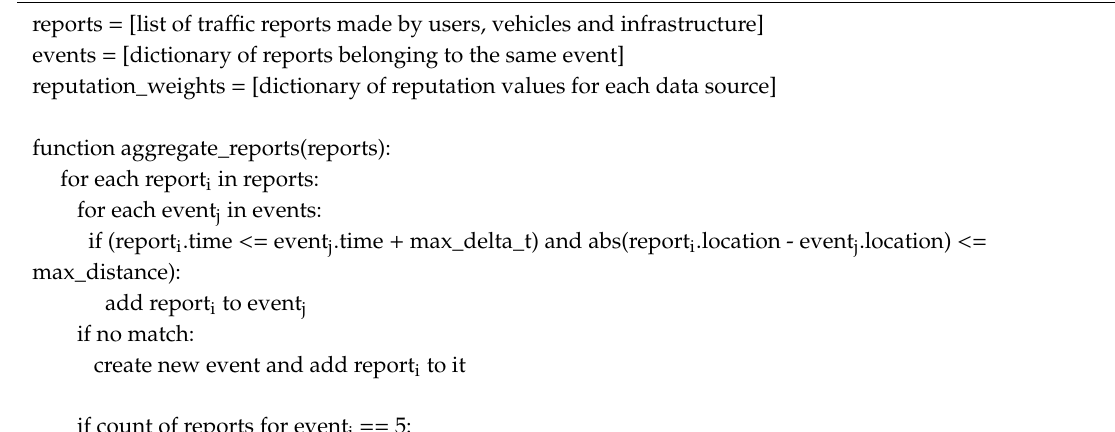
Algorithm 1: Pseudocode of blockchain